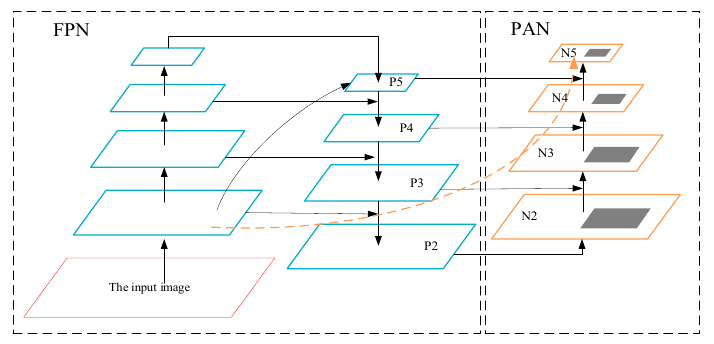
Figure 7. PANet network structure.